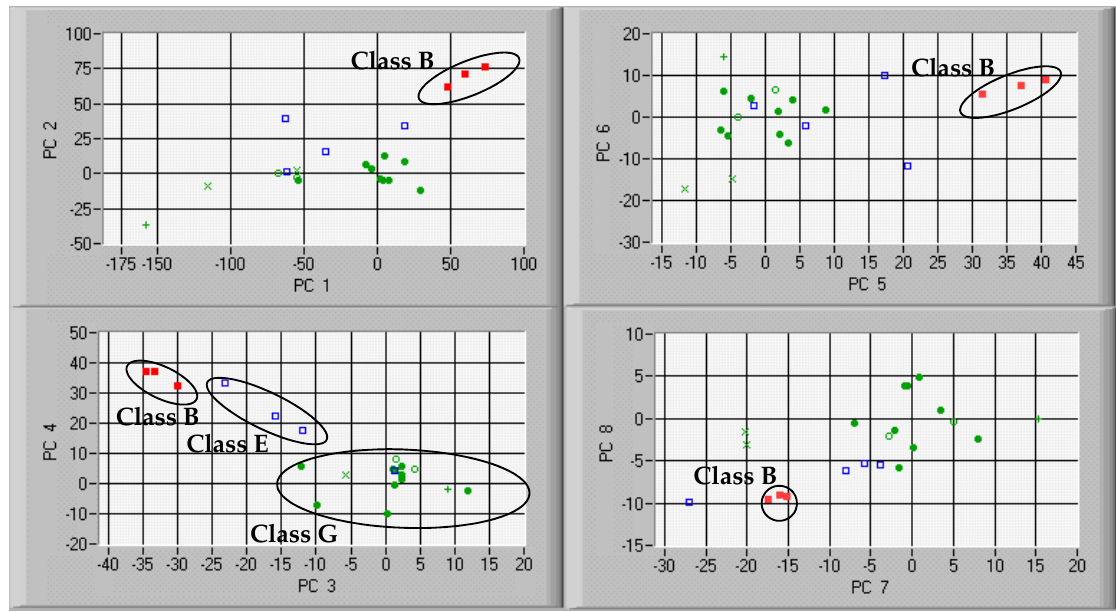
Figure 10. Representation of devices by PC1–PC8 for acquisition time equal to 7.5 min.